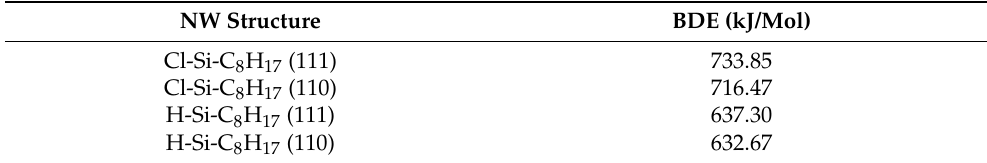
Table 3. Bond dissociation energy values of the modelled